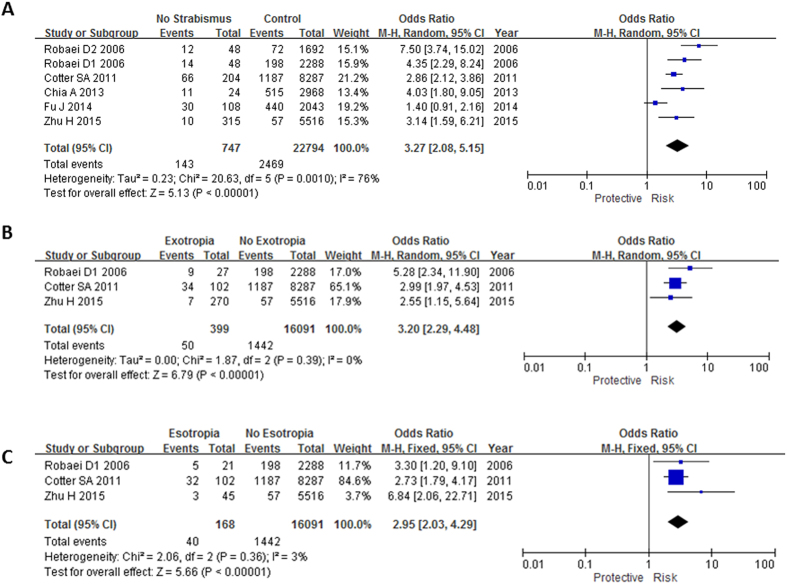
Meta-analysis of the association of astigmatism with different types of strabismus.The bars with squares in the middle represent 95% confidence intervals (95% CIs) and odds ratios (ORs). The central vertical solid line indicates the ORs for the null hypothesis. Diamond indicates summary OR with its corresponding 95% CI. (A) Association between astigmatism and strabismus. (B) Association between astigmatism and exotropia. (C) Association between astigmatism and esotropia.